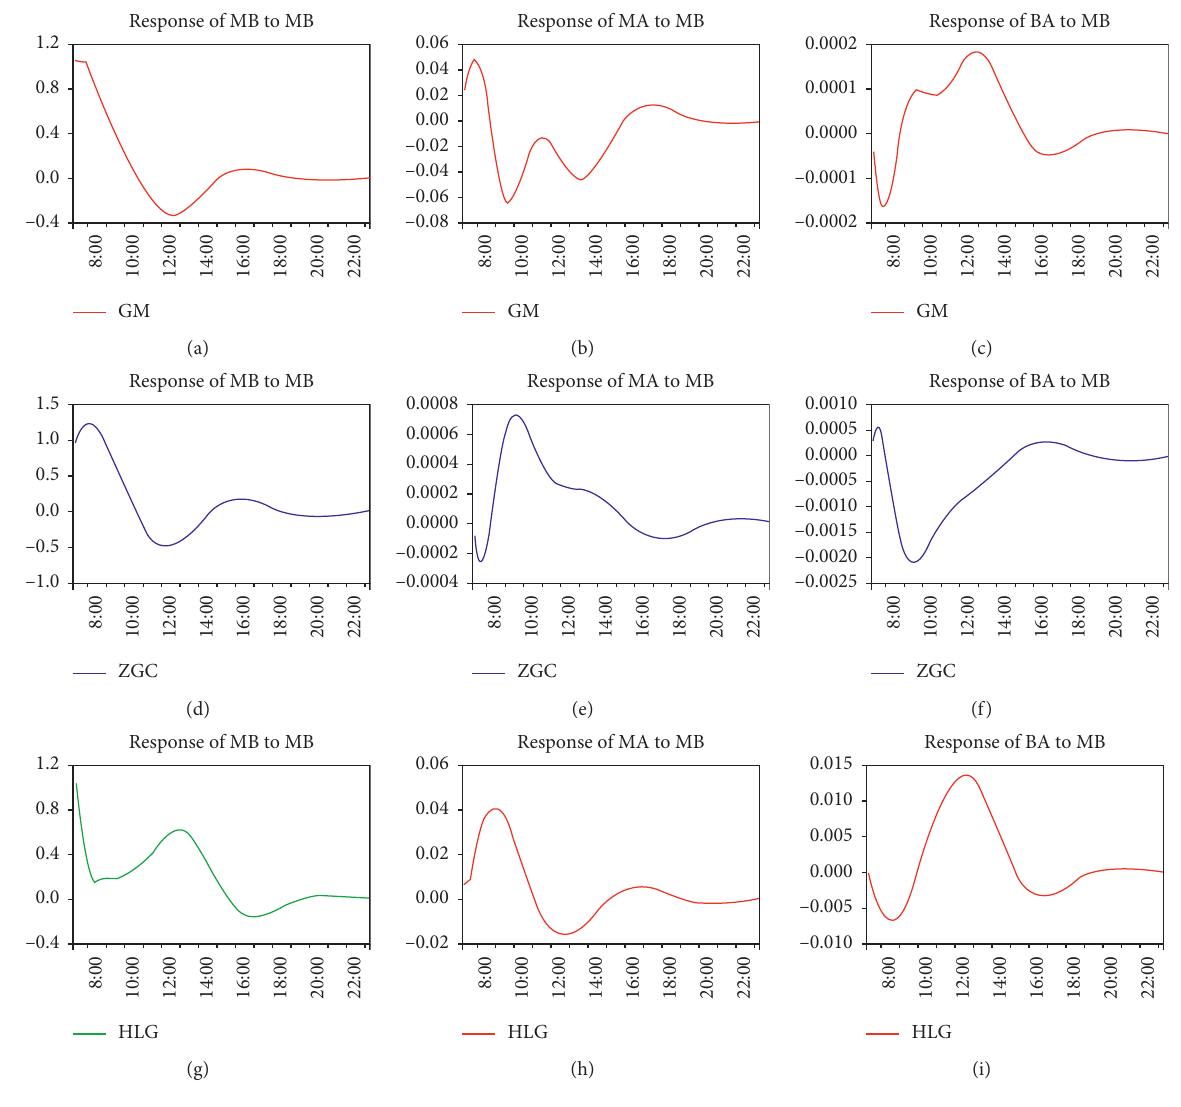
Figure 3: Intraregional passenger flow impulse response at 7: 00.